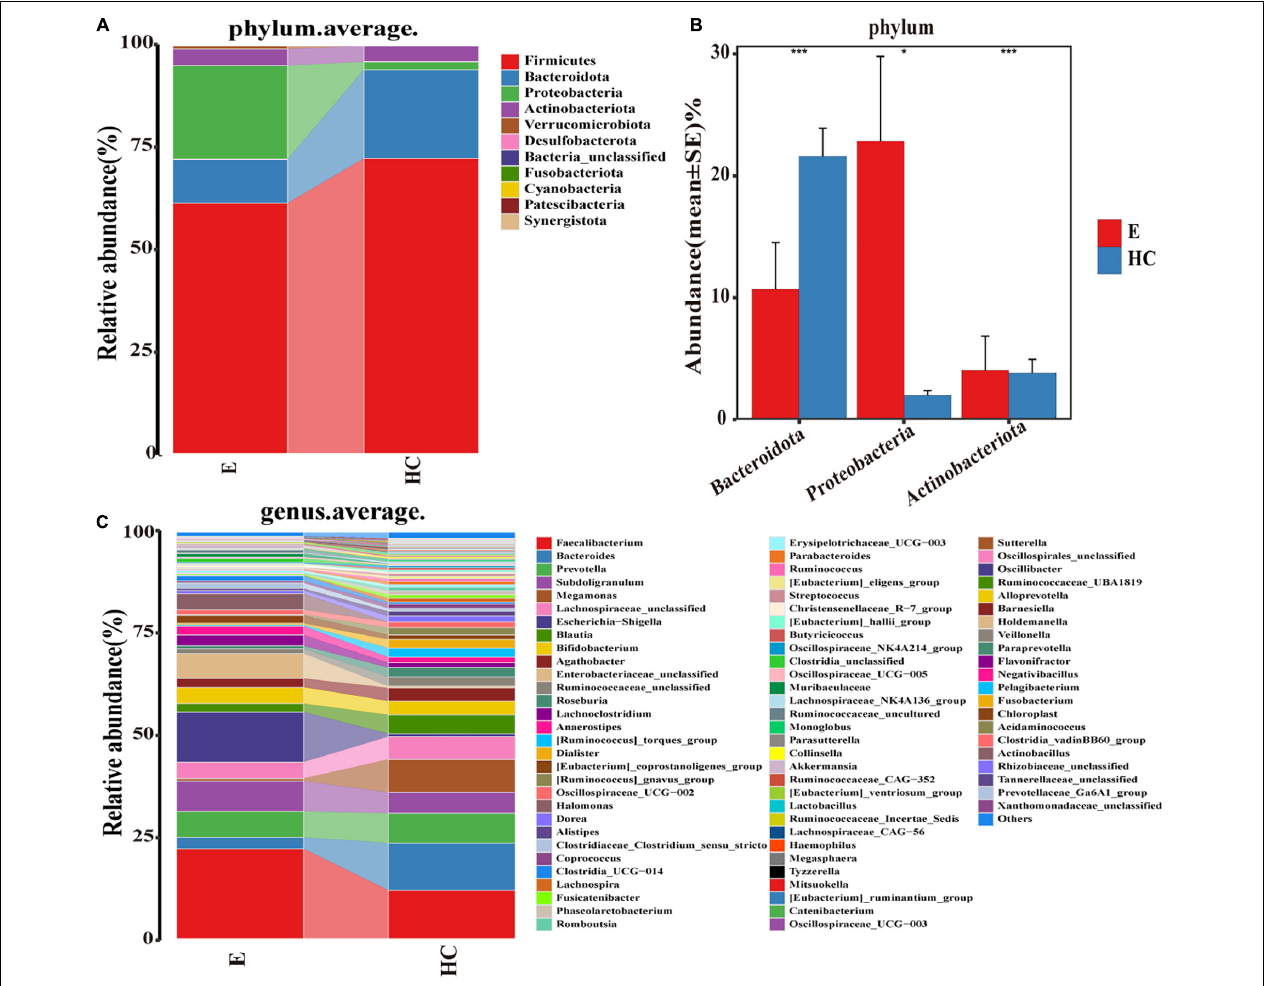
FIGURE 5 | Composition and comparison of fecal microbiomes in Eps ( n = 24) and HCs ( n = 50). Composition of the fecal microbiota at the (A) phylum and (C) genus levels in Eps versus HCs. Comparison of the fecal microbiota at the (B) phylum between the two groups. Significant differences in the abundance of predominant genera between Eps and HCs (blue). The average abundance of each bacterium is depicted as the mean ± SE. P -values were calculated by a Wilcoxon rank-sum test and are shown in the Supplementary Data . * P < 0.05; *** P < 0.001; Eps, patients with epilepsy; HCs, healthy controls.